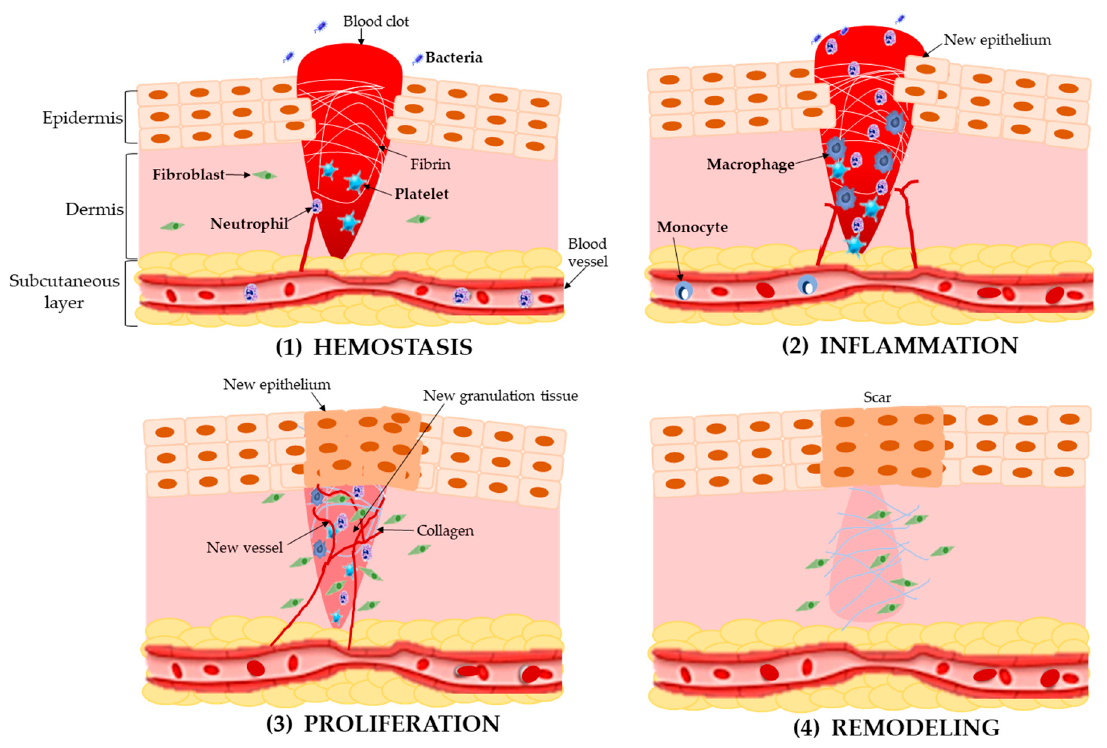
Figure 1. Wound healing process. ( 1 ) Hemostasis (coagulation); ( 2 ) inflammation (early/late inflam- mation); ( 3 ) proliferation (proliferation/migration/epithelialization/granulation); ( 4 ) remodeling (maturation/repair).